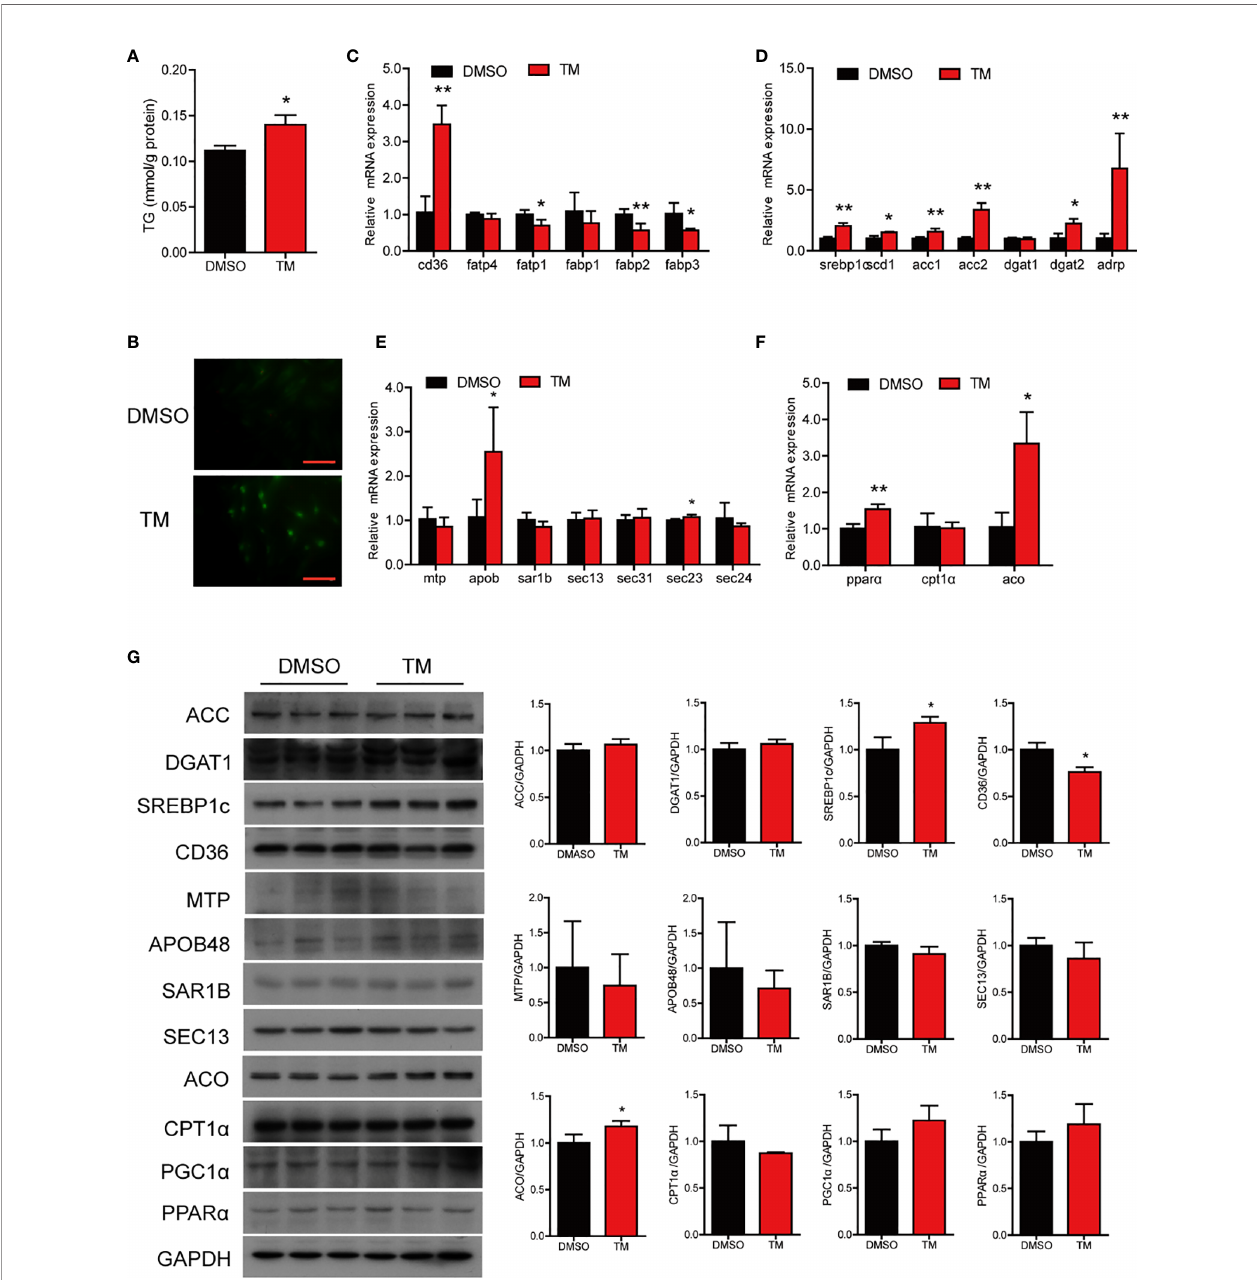
FIGURE 5 | ER stress disrupted lipid metabolism homeostasis in the isolated intestinal cells of large yellow croaker in vitro . (A) TG content in the intestinal cells after TM treatment for 12 h (n = 3). (B) Lipid droplets in cells stained with BODIPY 493/503 (magni fi cation: 200×, scale bars: 60 m m). Relative mRNA expression of fatty acid uptake (C) , lipid synthesis (D) , chylomicron secretion (E), and fatty acid b -oxidation (F) in the isolated intestinal cells of large yellow croaker after TM treatment for 12 h (n = 3). (G) Western blot analysis of lipid metabolism related protein levels in the isolated intestinal cells of large yellow croaker after TM treatment for 12 h (normalized to GAPDH, n = 3). cd36 , fatty acid translocase; fatp1 , fatty acid transport protein 1; fatp4 , fatty acid transport protein 4; fabp1 , fatty acid-binding protein 1; fabp2 , fatty acid-binding protein 2; fabp3 , fatty acid-binding protein 3; srebp1c , sterol regulatory element binding protein 1 c; scd1 , stearoyl-CoA desaturase 1; acc1 , acetyl-CoA carboxylase 1; acc2 , acetyl-CoA carboxylase 2; dgat1 , diacylglycerol acyltransferase 1; dgat2 , diacylglycerol acyltransferase 2; adrp , adipose differentiation-related protein; mtp , microsomal triglyceride transfer protein; apob , apolipoprotein; sar1b , secretion associated Ras related GTPase 1B; sec13 , sec13 homolog, nuclear pore and COPII coat complex component; sec31 , sec31 homolog A, COPII coat complex component; sec23 , sec23 homolog A, coat complex II component; sec24 , sec24 homolog A, COPII coat complex component; ppar a , peroxisome proliferator-activated receptor alpha; cpt1 a , carnitine palmitoyl transferase 1 alpha; aco , acyl-CoA oxidase; PGC1 a , peroxisome proliferator-activated receptor gamma coactivator 1alpha; GAPDH, glyceraldehyde-3-phosphate dehydrogenase. Results were analyzed using independent t -test (* P < 0.05, ** P < 0.01), and they were presented as mean ± standard